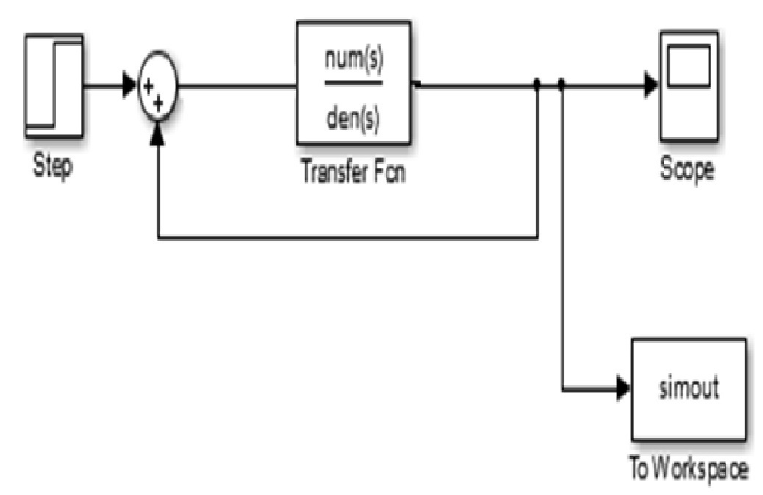
Figure 8. SIMULINK Model for Drug Delivery System without Controller.